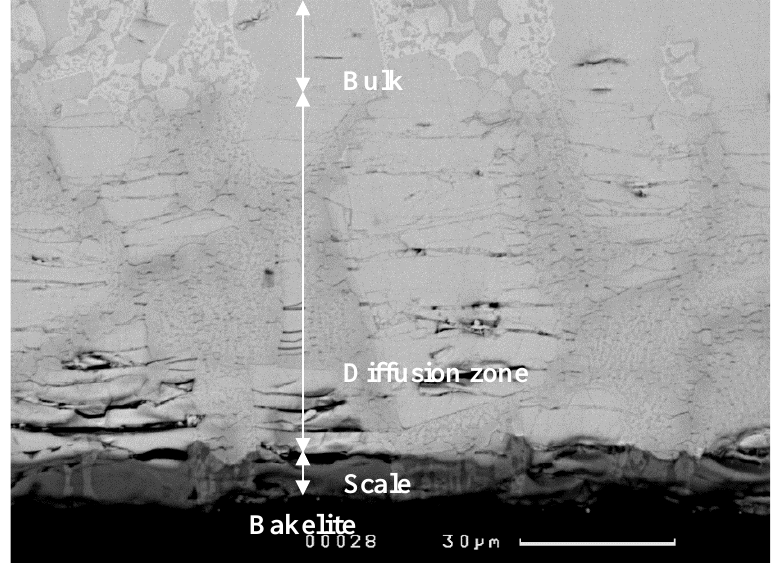
Figure 6. BSE image showing the typical microstructures of a cross-section of the alloy ZF5 after oxidation in air at 800 °C for 100 h. Table 4. The composition of constituent phases in the di ff usion zone and bulk in the oxidised alloy ZF5. Area